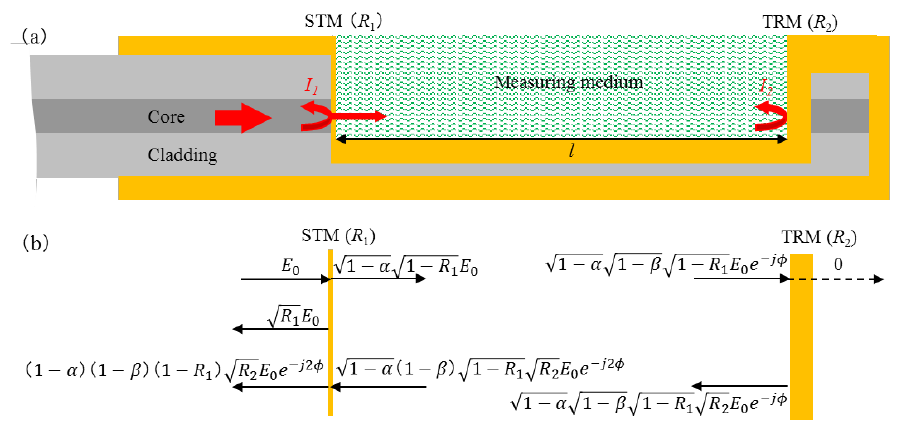
Figure 1. ( a ) The schematic diagram of the FFPI sensor head, showing that the gold films of various thicknesses (yellow part) are sputtered on the inner surfaces of the micro-cavity as a STM and a TRM in the direction of optical axis; ( b ) transmission and reflection model.